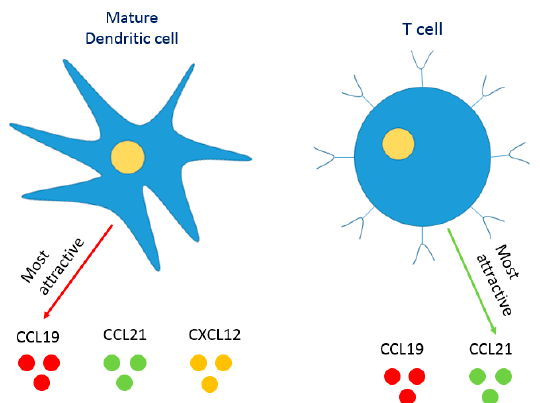
Figure 3. Response of different immune cells to chemokine gradients. Based on the work by [97,98], mature dendritic cells are much more attracted to the chemokine CCL19 than they are to the chemokines CCL21 or CXCL12. Interestingly, under physiological gradient.